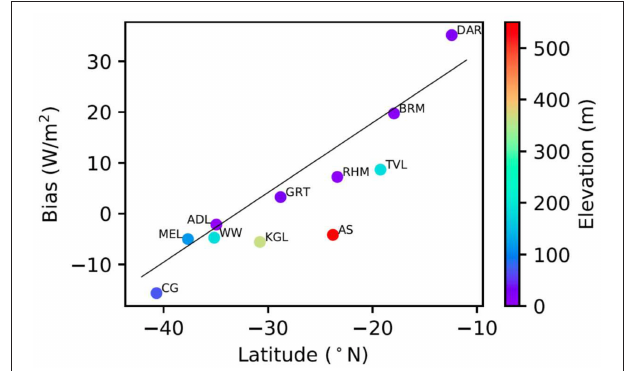
FIGURE 12 | Dependence of the original flux bias on latitude and elevation, providing a way to correct the calculated flux. The points are labeled with site ID ( Table 2 ) and the color of the circles indicates the elevation of the sites. The black line is the least square linear regression of the original bias after elevation correction (see